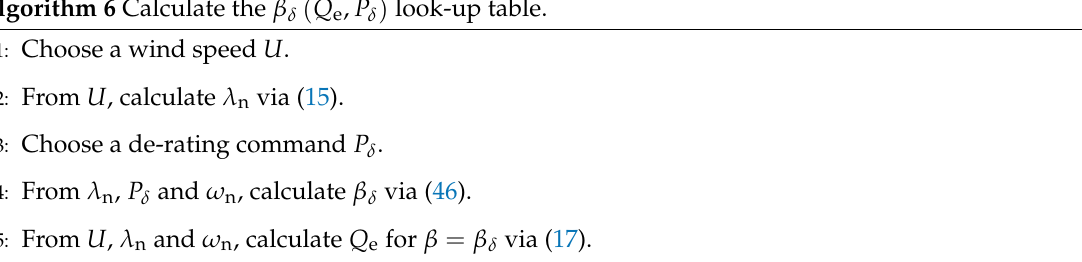
Algorithm 6 Calculate the β δ ( Q e , P δ ) look-up